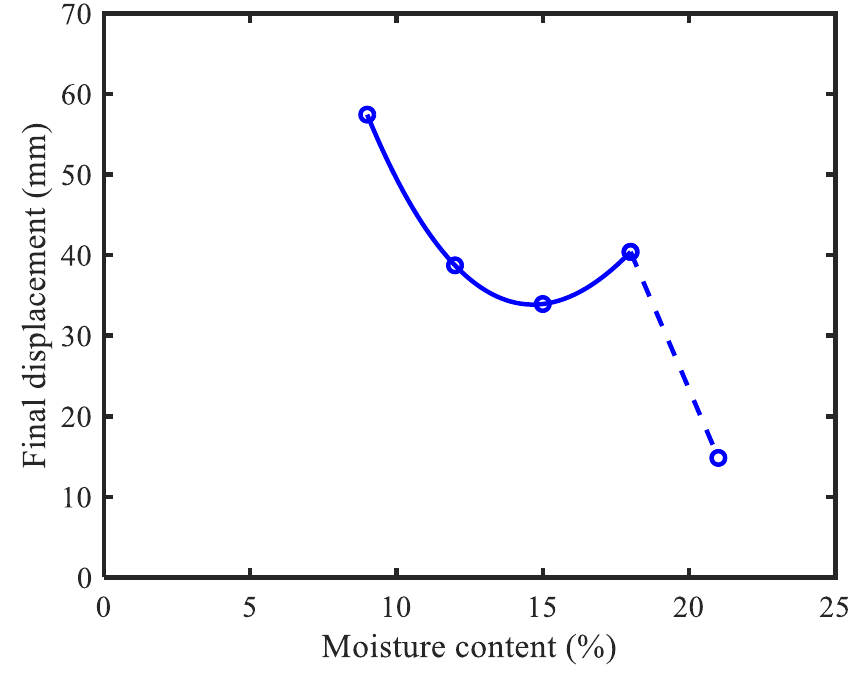
Figure 9. Relation between the final displacement and moisture content. During the continuous loading process, changes in the particle mesostructure of the tailings specimen were observed in real time using a stereo microscope and CCD camera; the mesostructure images at different moments were captured. Considering the sample with a moisture content of 15%, the original and binary images of the mesostructure of the tailings particles at different times are shown in Figure 10. The binary images, where the black represents particles and white represents pores, were obtained using the CF2000P polarized light analysis program (manufactured by Shanghai Changfang Optical Instrument Co. Ltd., Shanghai, China). Due to certain unfavorable factors, such as the pore water adhering to the inner wall of the observation window, the movement of particles scratching the observation window, and observation window with a certain curvature instead of a plane, the mesostructure image clarity was